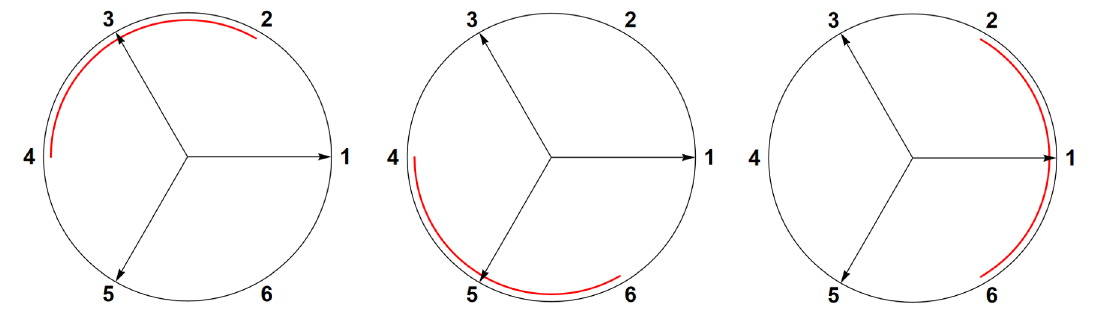
Figure 4 . Planar basis relations for the n = 6 split kinematics given by the partition (1 , 3 , 5) . Here s 234 = s 23 + s 34 , s 456 = s 45 + s 56 , and s 612 = s 61 + s 12